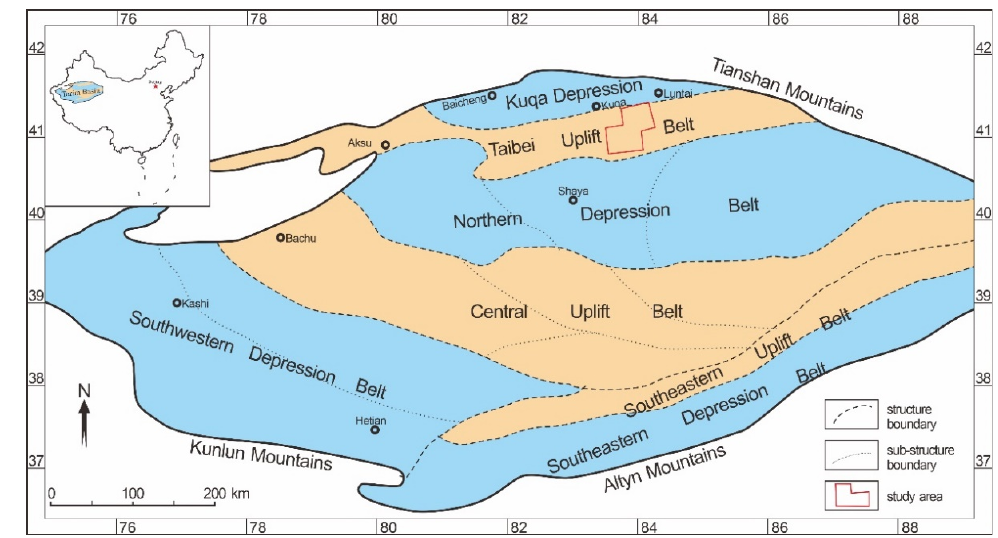
Figure 1. Structural map of Tarim Basin and the location of the study area. The strata revealed in the study area include (from bottom to top) Proterozoic, Upper Cambrian, Lower Ordovician, Upper Devonian, Lower Carboniferous, Upper Triassic, Lower Jurassic, Lower Cretaceous, Paleogene, Neogene, and Quaternary (Figure 2). The target layer of this research is the clastic reservoir in the Cretaceous Yageliemu Formation (K 1